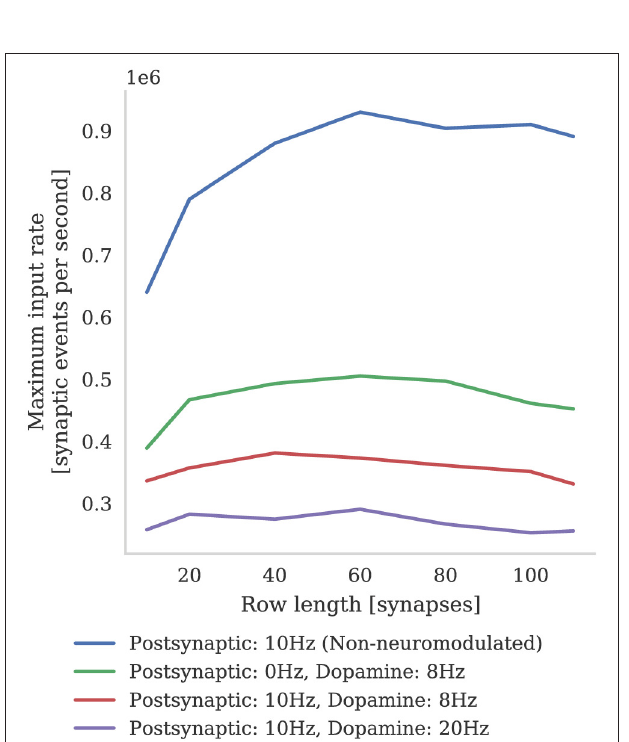
FIGURE 6 | Comparison between incoming spike processing performance of standard STDP (with an additive weight dependence) and three-factor STDP for different post-synaptic spiking rates.